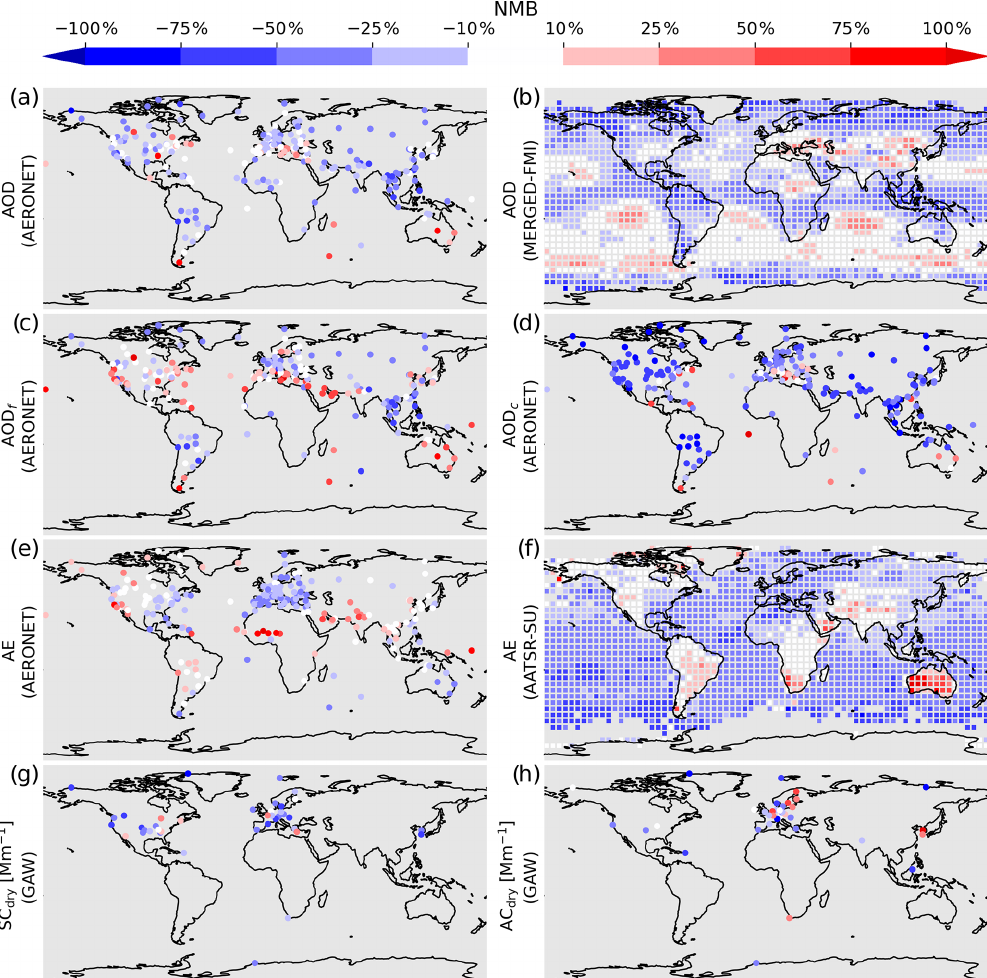
Figure 5. Yearly average NMBs of the ensemble median AOD against several observation records. First row: AODs from AERONET and merged satellite data set. Second row: fine and coarse AODs from AERONET. Third row: AE from AERONET and AATSR-SU satellite data set. Fourth row: surface dry scattering and absorption coefficients from GAW in situ